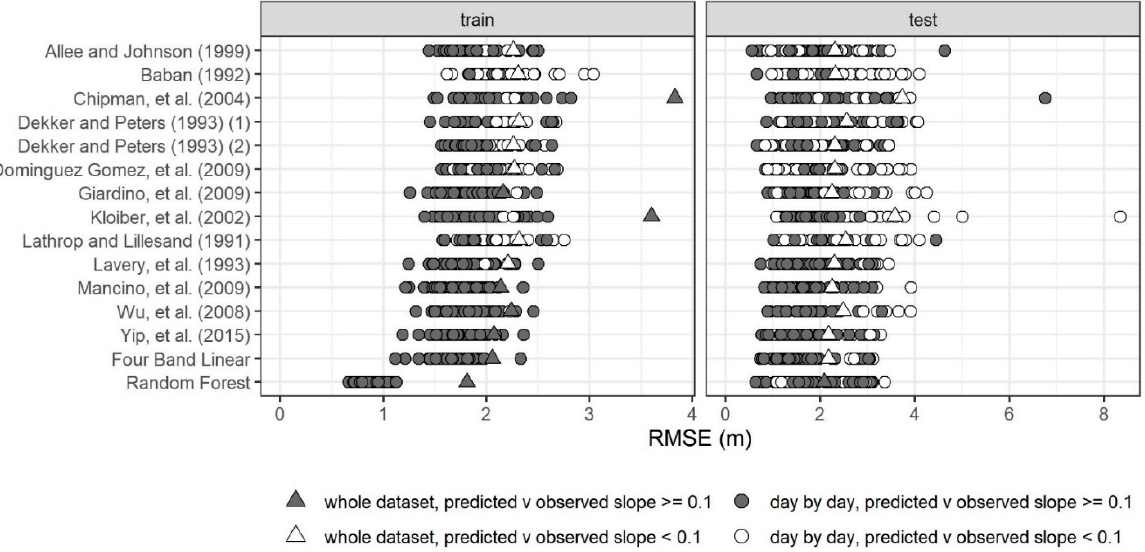
Figure 3. RMSE for the training ( left ) and test ( right ) subsets for the whole dataset (triangle) as compared to the day-by-day analyses (circles). Icons for the datasets are colored by the slope of the relationship between predicted and observed. Unfilled circles indicate a static predicted Secchi depth (predicted-observed slope < 0.1), gray fill indicates some response in the predicted Secchi depth such that there is a positive slope (>=0.1) in the relationship between predicted and observed Secchi depth. Note the difference in the x-axis scale between the two panels.